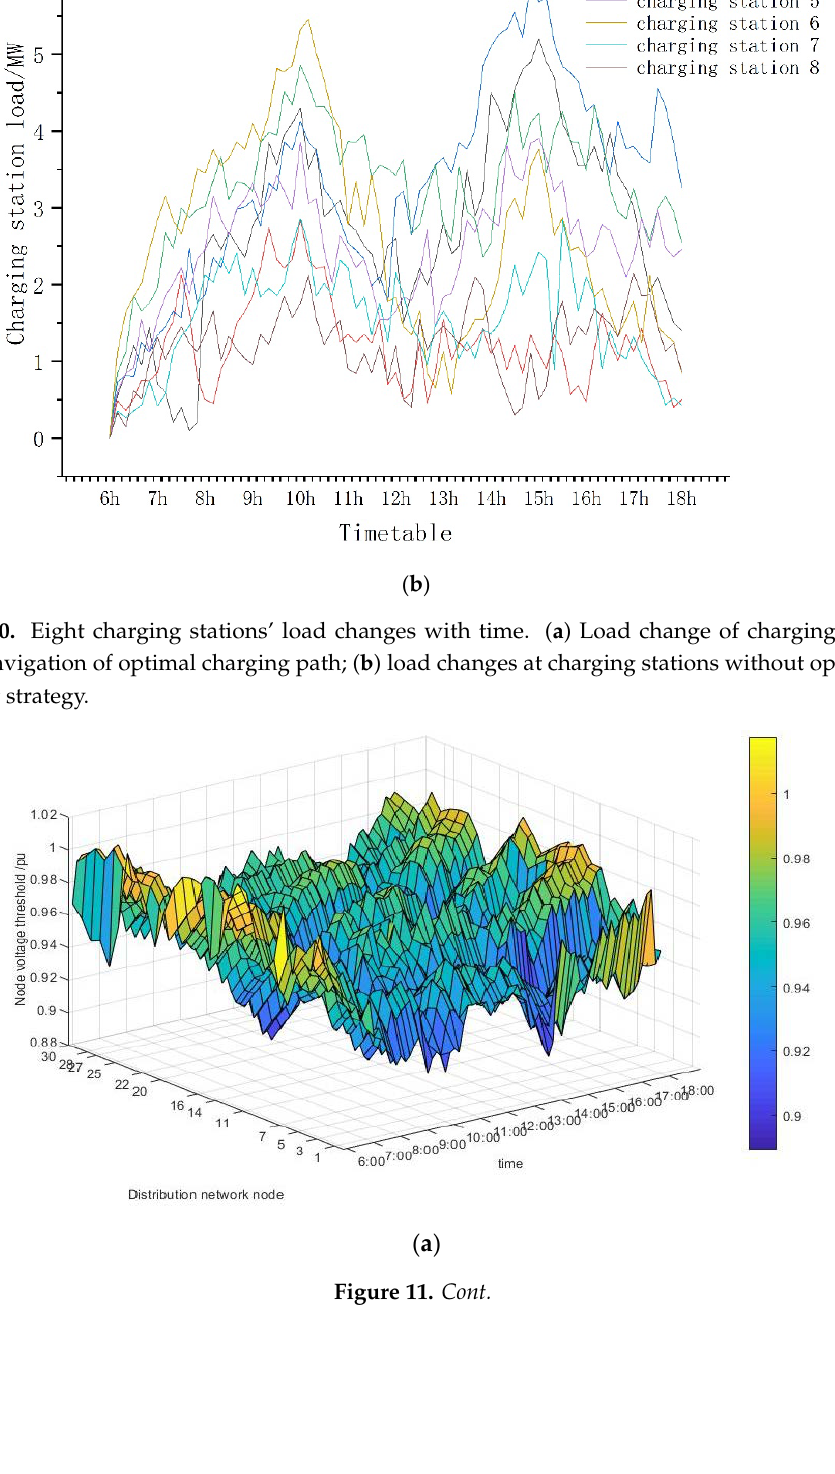
Figure 10. Eight charging stations’ load changes with time. ( a ) Load change of charging station under navigation of optimal charging path; ( b ) load changes at charging stations without optimized charging strategy.